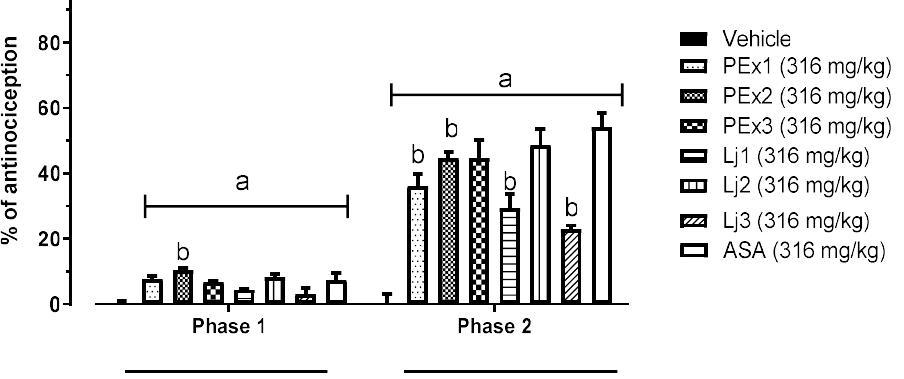
Figure 2. Percentage of antinociception of the different study groups by phases in the formalin test. a = Statistically significant difference versus Vehicle ( p < 0.05), b = Statistically significant difference versus ASA ( p < 0.05).